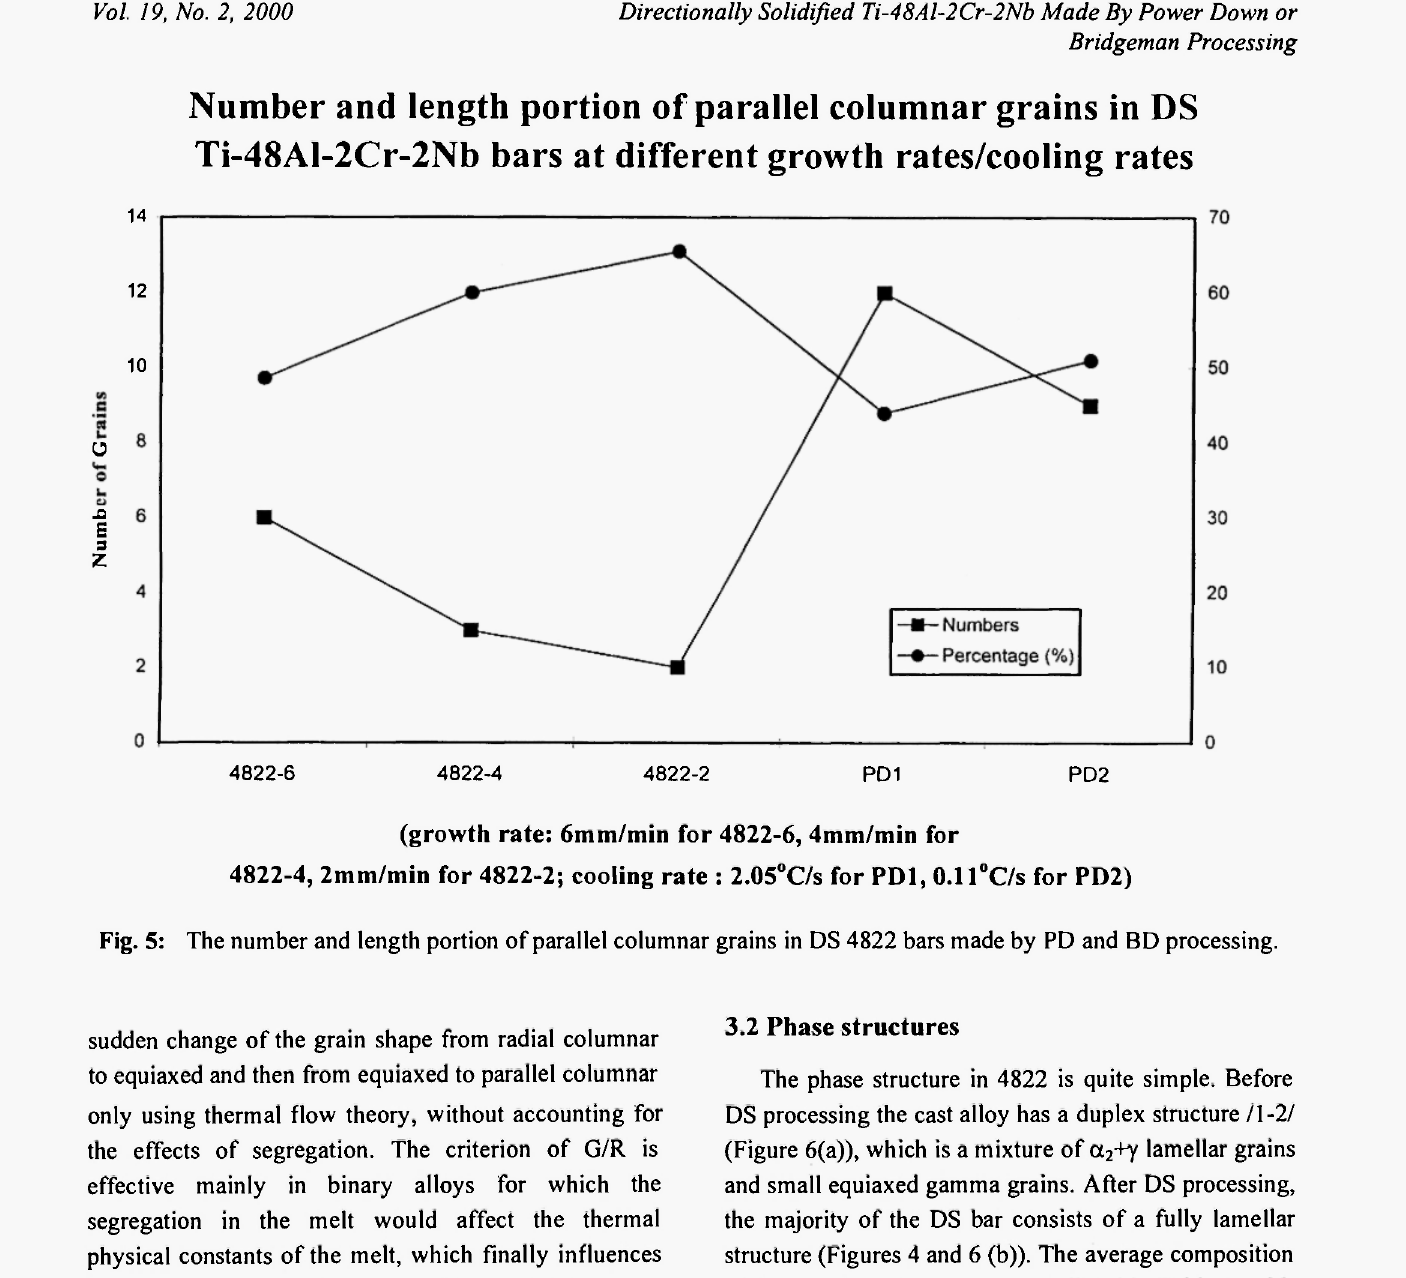
sudden change of the grain shape from radial